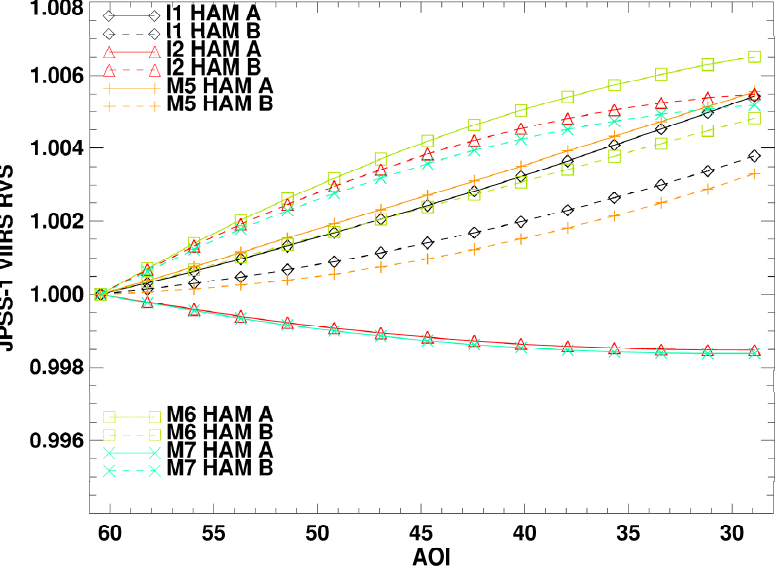
Figure 9. Band-averaged RVS for JPSS-1 VIIRS from the SV AOI to the end of scan AOI for bands I1, I2 and M5–M7.